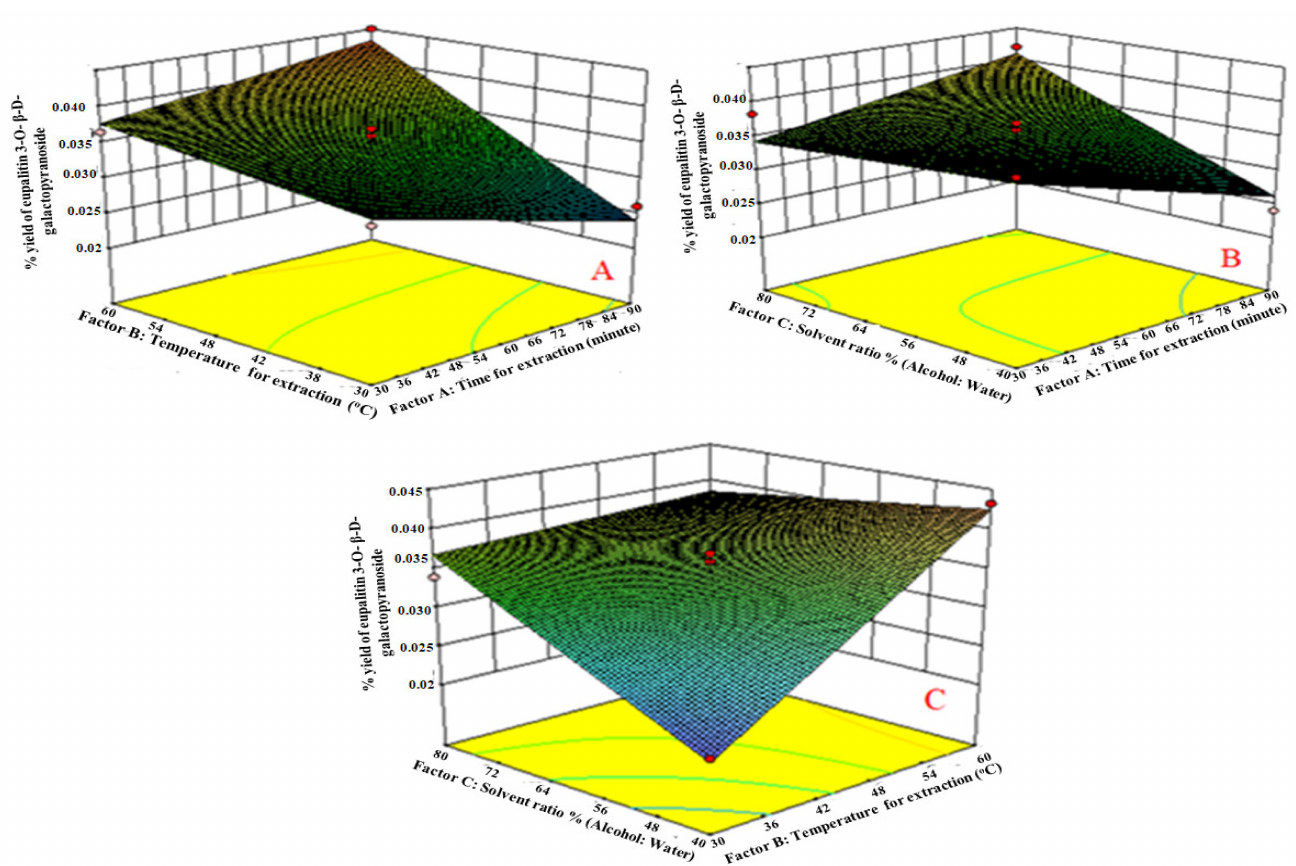
Figure 4. ( A ) Response surface plots of factor B 2 vs. A 1 against eupalitin-3- O - β - D -galactopyranoside: when time of extraction increases, the % yield of eupalitin-3- O- β -D -galactopyranoside also increases due to time required to penetrate solvent into plant materials; ( B ) response surface plots of factor C 3 vs. B 2 against eupalitin-3- O - β - D -galactopyranoside: As the temperature increases, the % yield of eupalitin-3- O - β - D -galactopyranoside also increases, respectively, due to thermo stable compounds; ( C ) response surface plots of factor C 3 vs. A 1 against eupalitin- 3-O- β -D -galactopyranoside: the solvent ratio was higher, and the yield of eupalitin-3- O- β -D -galactopyranoside was higher. This could be attributed to the compound’s medium